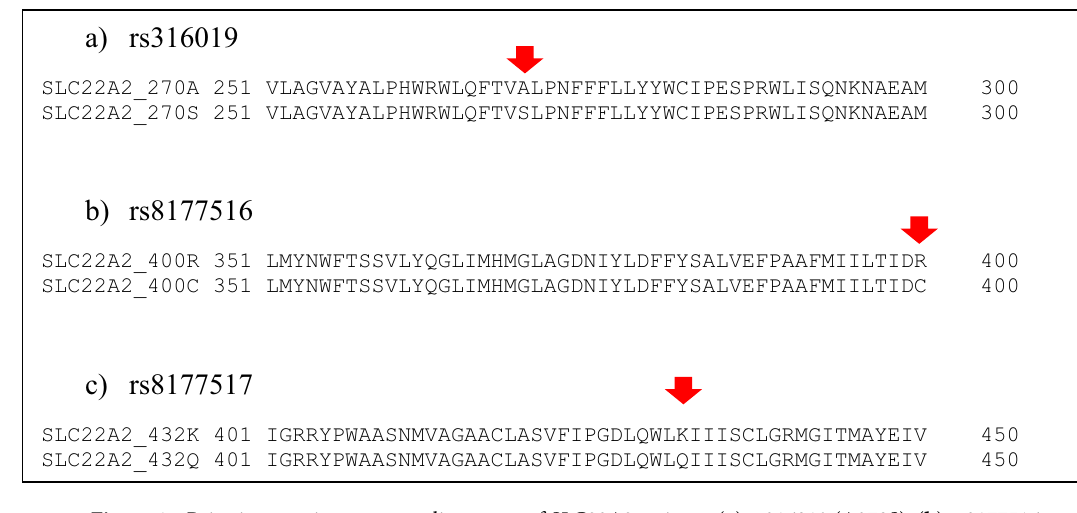
Figure 1. Pairwise protein sequence alignments of SLC22A2 variants: ( a ) rs316019 (A270S), ( b ) rs8177516 (R400C) and ( c ) rs8177517 (K432Q) (variant position indicated by red arrow).